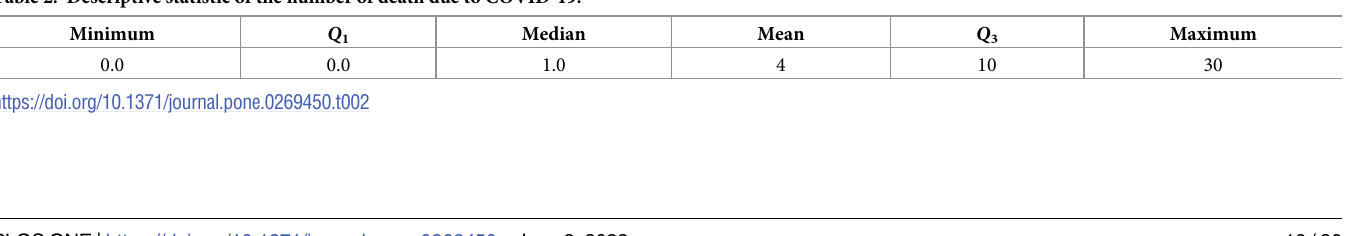
Table 2. Descriptive statistic of the number of death due to